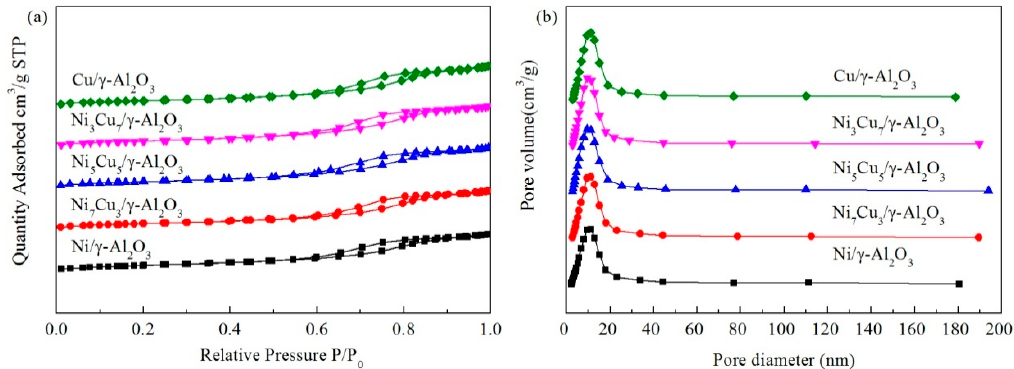
Figure 2. N 2 adsorption–desorption isotherms ( a ) and pore size distributions ( b ) of the Ni x Cu (10 − x ) / γ -Al 2 O 3 catalysts.